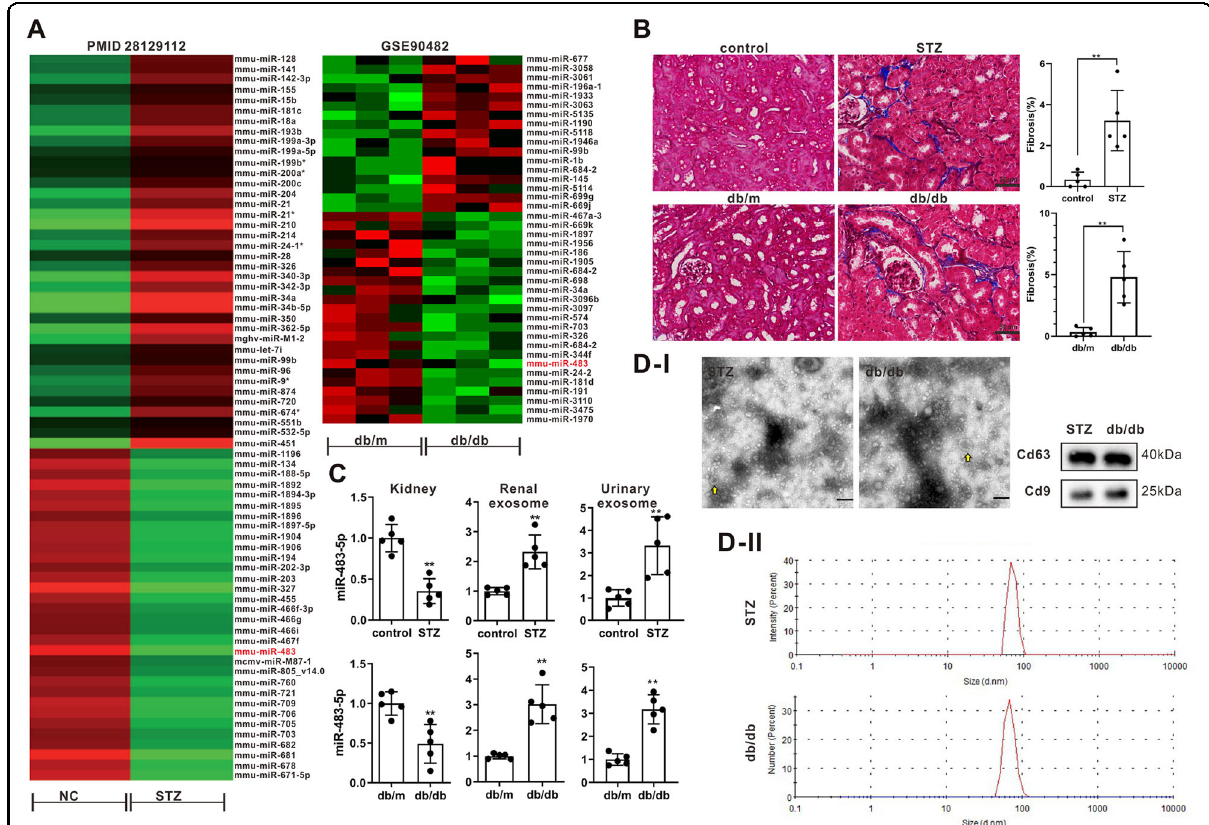
Fig. 1 The expressions of miR-483-5p in kidney tissues and exosomes derived from the renal tissues in type 1 and type 2 diabetic mice. A PubMed database and GEO datasets (GSE90482) were applied to identify miRNAs that related to diabetic. B Masson staining of kidney tissues in type 1 and type 2 diabetic mice (Scale Bar = 50 μ m). C Detection of the expressions of miR-483-5p in the kidney tissues and exosomes derived from renal tissues and urine in diabetic mice by quantitative real-time PCR (qRT-PCR). D Transmission Electron Microscope (TEM) was applied to identify exosomes (arrows pointed to exosomes, Scale Bar = 200 nm), and detection of the protein levels of exosome markers CD63 and CD9 by western blot, and the size distribution of exosomes. ** P < 0.01 vs. control or db/m. Student ’ s t -test. STZ Streptozotocin, db/m